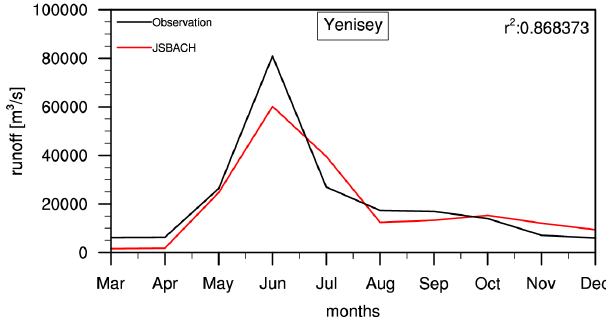
Fig. 18. Simulated and observed monthly mean Yenisey River runoff. Line colors are as in Fig. 17. As for the simulated Lena River runoff in Fig. 16, the model results are shifted 2 months to match the actual peak time in spring due to the lack of river routing scheme in the